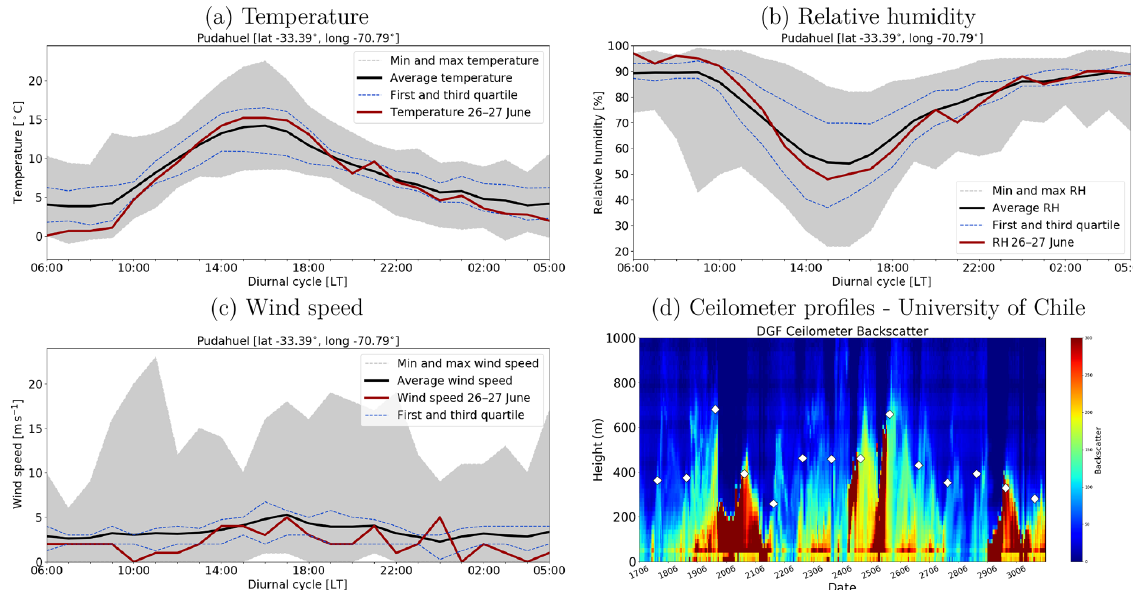
Figure 5. Meteorological conditions around 26–27 June PM 2 . 5 episode for the synoptic station Pudahuel. (a–c) Average (black line), minima and maxima (gray area), and 25th and 75th percentiles (dashed blue line) between 15 June and 15 July 2016. The red lines show the values for 26 June 06:00LT to 27 June 05:00LT. (d) Department of Geophysics (DGF) ceilometer hourly backscatter profiles from 17 June through 30 June 2016 and mixed-layer height at 15:00LT (diamond white markers).